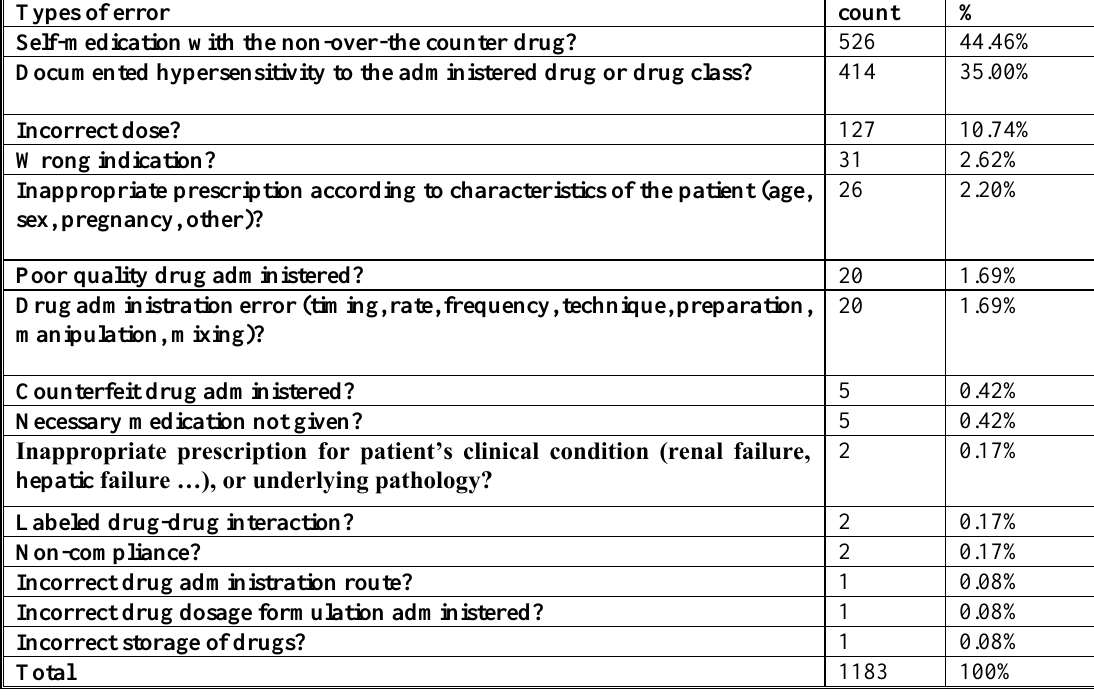
Table 6. Types of errors according to the P method. Types of error